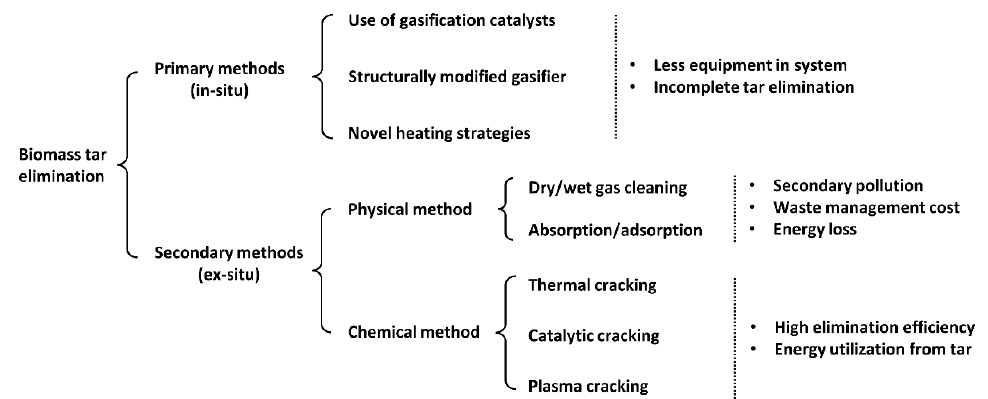
Figure 1. Biomass tar elimination method and their properties.